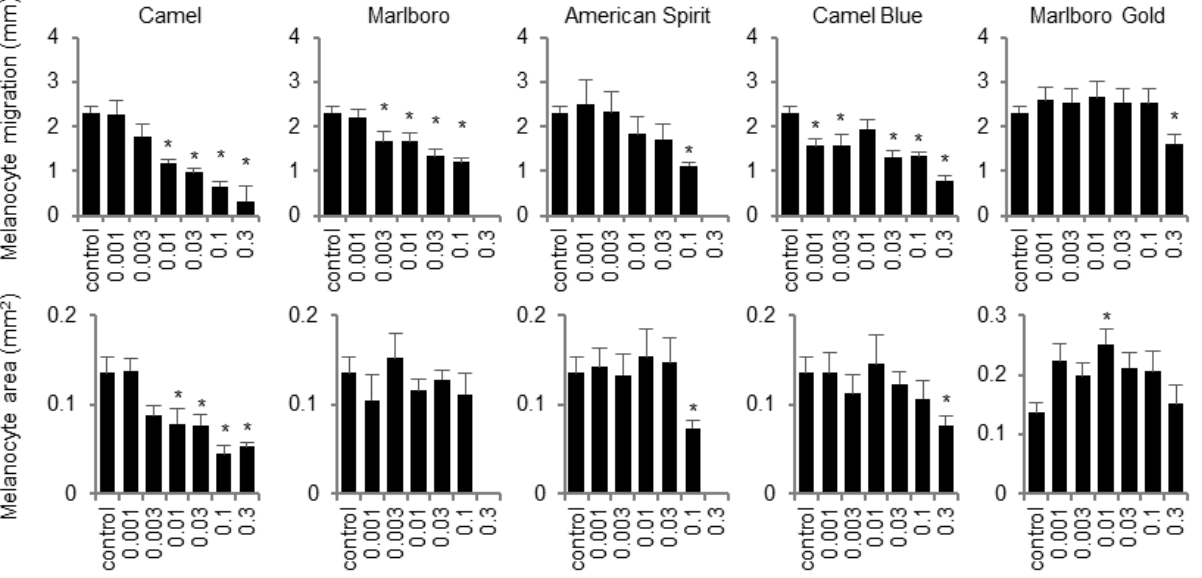
Figure 7. Exposure to tobacco smoke extract diminished melanocyte migration. E3 embryo media was dosed with tobacco smoke extract in concentrations as indicated at 5 hpf. The distance travelled and area of the location of melanocytes was assessed for surviving larvae at 6 dpf. X-axes represent SS smoke concentrations in puff equivalents (PE). * p < 0.05, one-way ANOVA with a Dunnett’s post hoc test to correct for multiple comparisons.